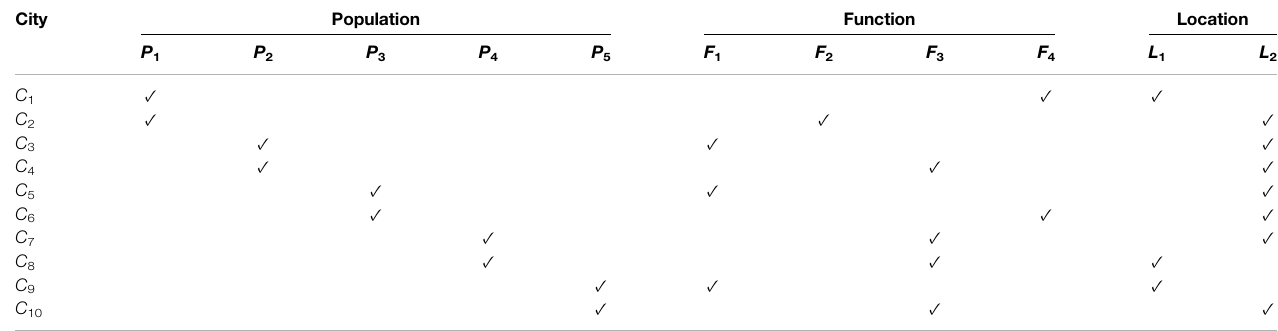
TABLE 3 | City classi fi cation